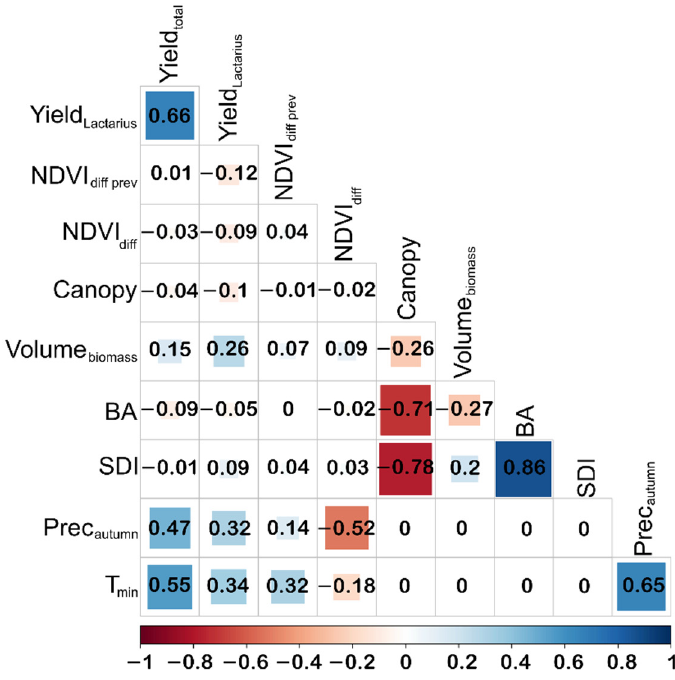
Figure 5. Pearson correlation between pairs of variables. Unravelling the complex relationship be- tween mushroom yield and its drivers may require powerful statistical tools. Generalised Additive Mixed Models (GAMM) are flexible in modelling complex variables and facilitate identification of the interaction between non-linear factors. Therefore, GAMM models were most suitable to predict mushroom yields with linear and non-linear variables, being more efficient and easier to interpret for all potential users. In addition, GAMMs were used with a random term, which in our case ac- counts for measuring errors at the plot level. The predictor function for a GAMM ( η ) has this general formula (Equation (1)):